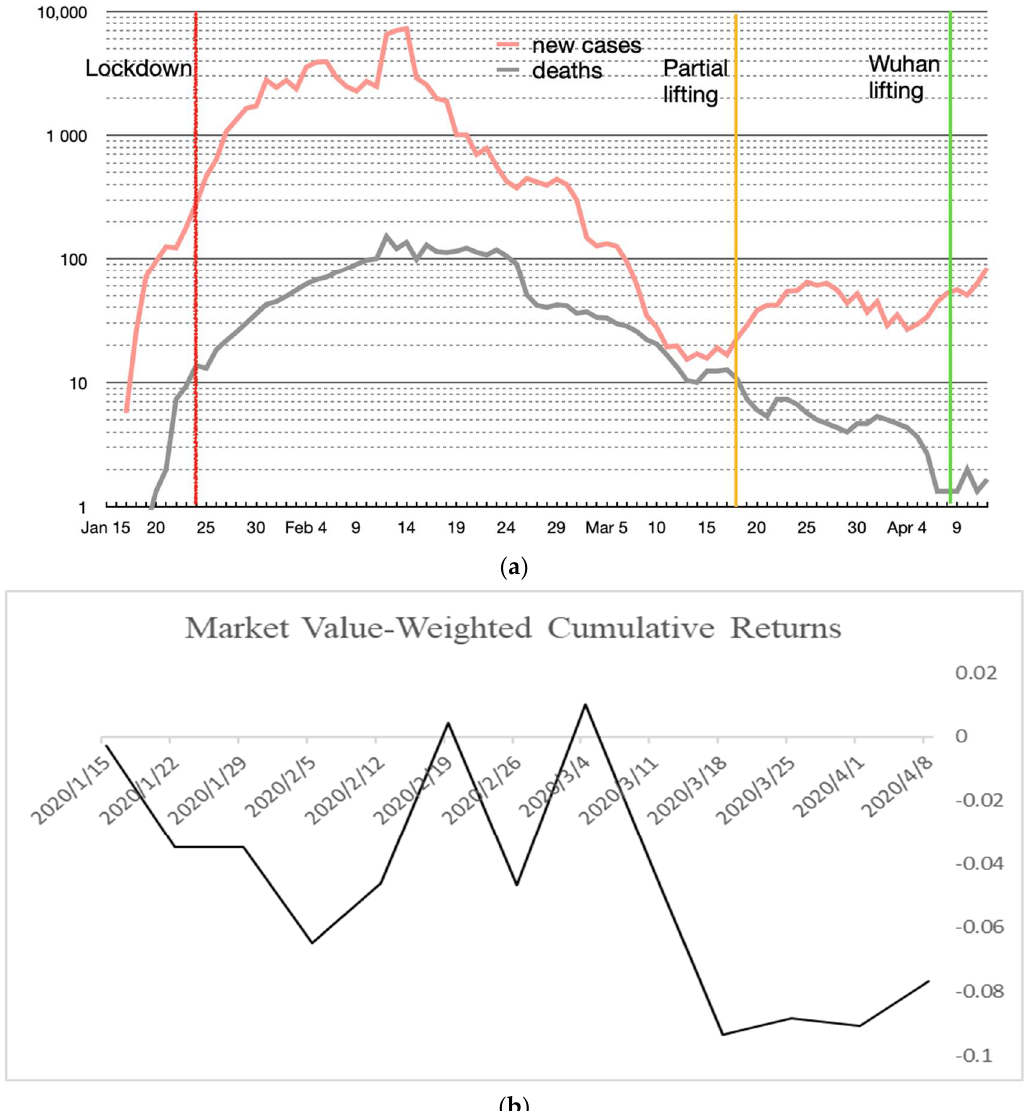
Figure 1. ( a ) COVID-19 cases and deaths in China with Hubei lockdown. Source: Wikimedia Commons; ( b ) market value-weighted cumulative returns. Source: CSMAR database.